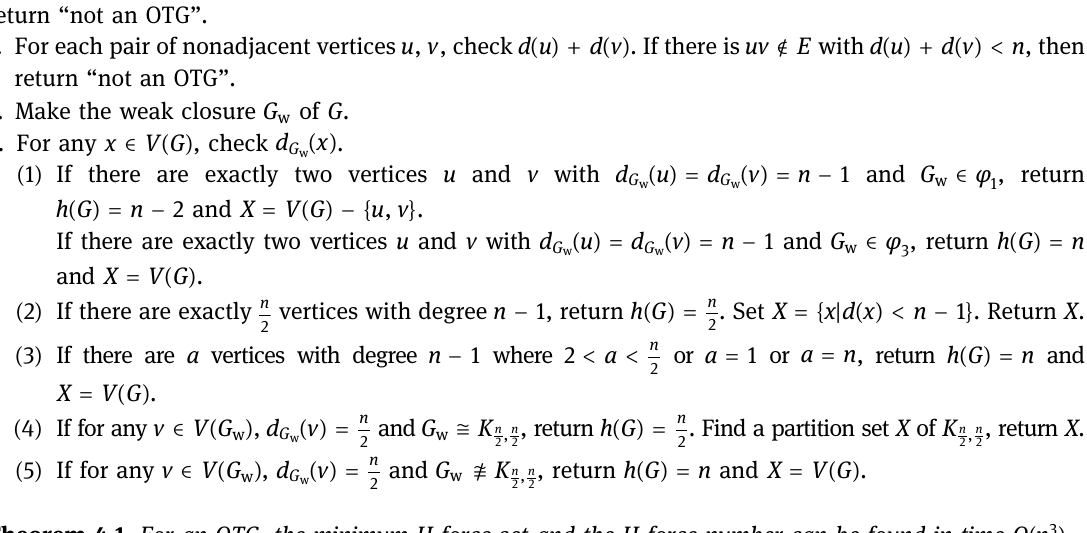
4 Algorithm to check the minimum H - force set of an